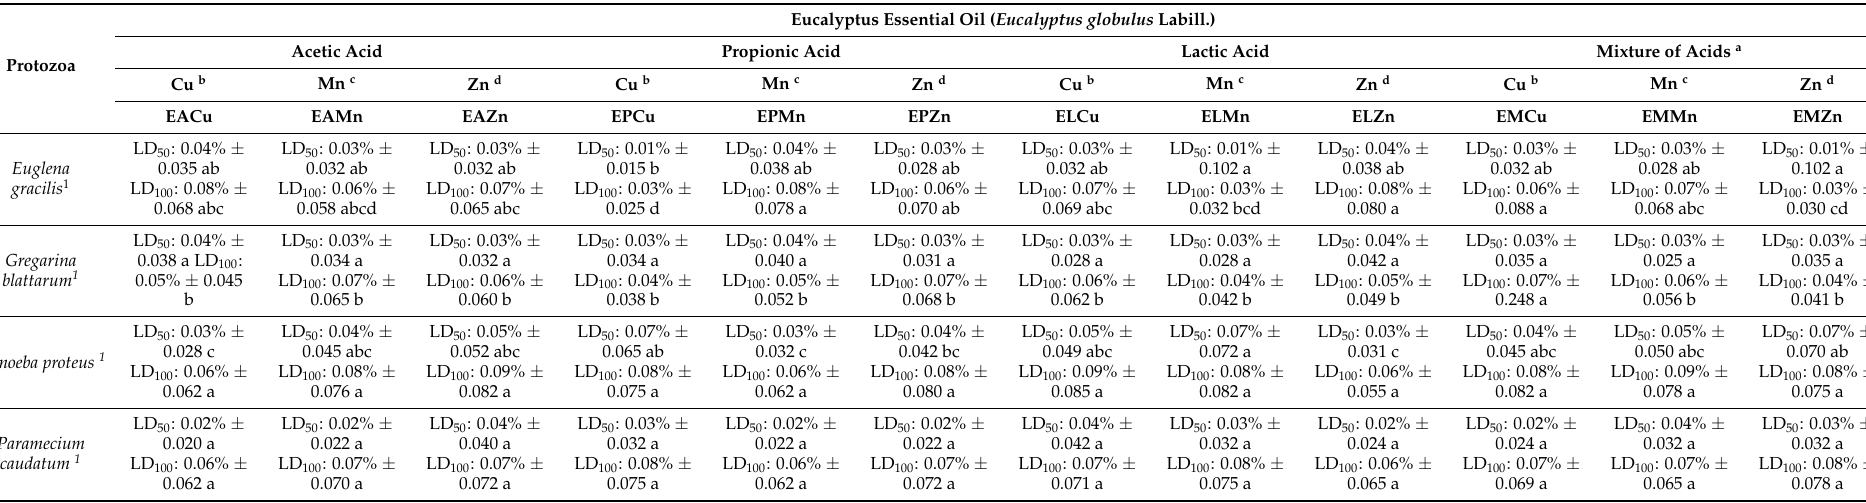
Table 3. LD 50 , LD 100 values for the tested mixtures of eucalyptus essential oil ( Eucalyptus globulus Labill.) (E), organic acids (Acetic acid—A, Propionic acid—P, Lactic acid—L, Mixture of acids—M) and metal ion against selected